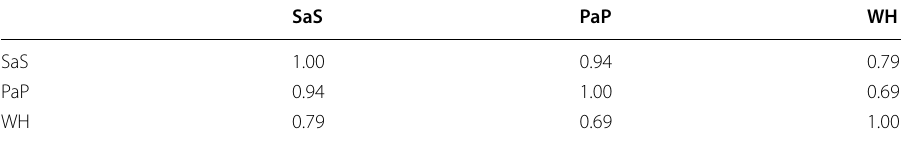
Table 3 Cosine similarity between novels